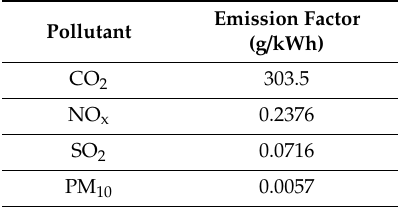
Table 6. Emission factors, reproduced from [76], ISPRA